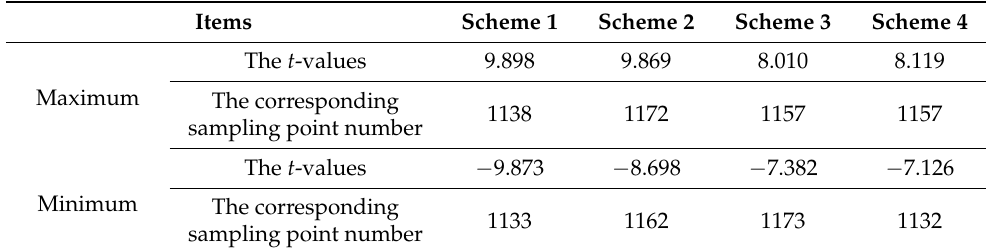
Table 1. The statistics of the t -values under a total sample size of 500.